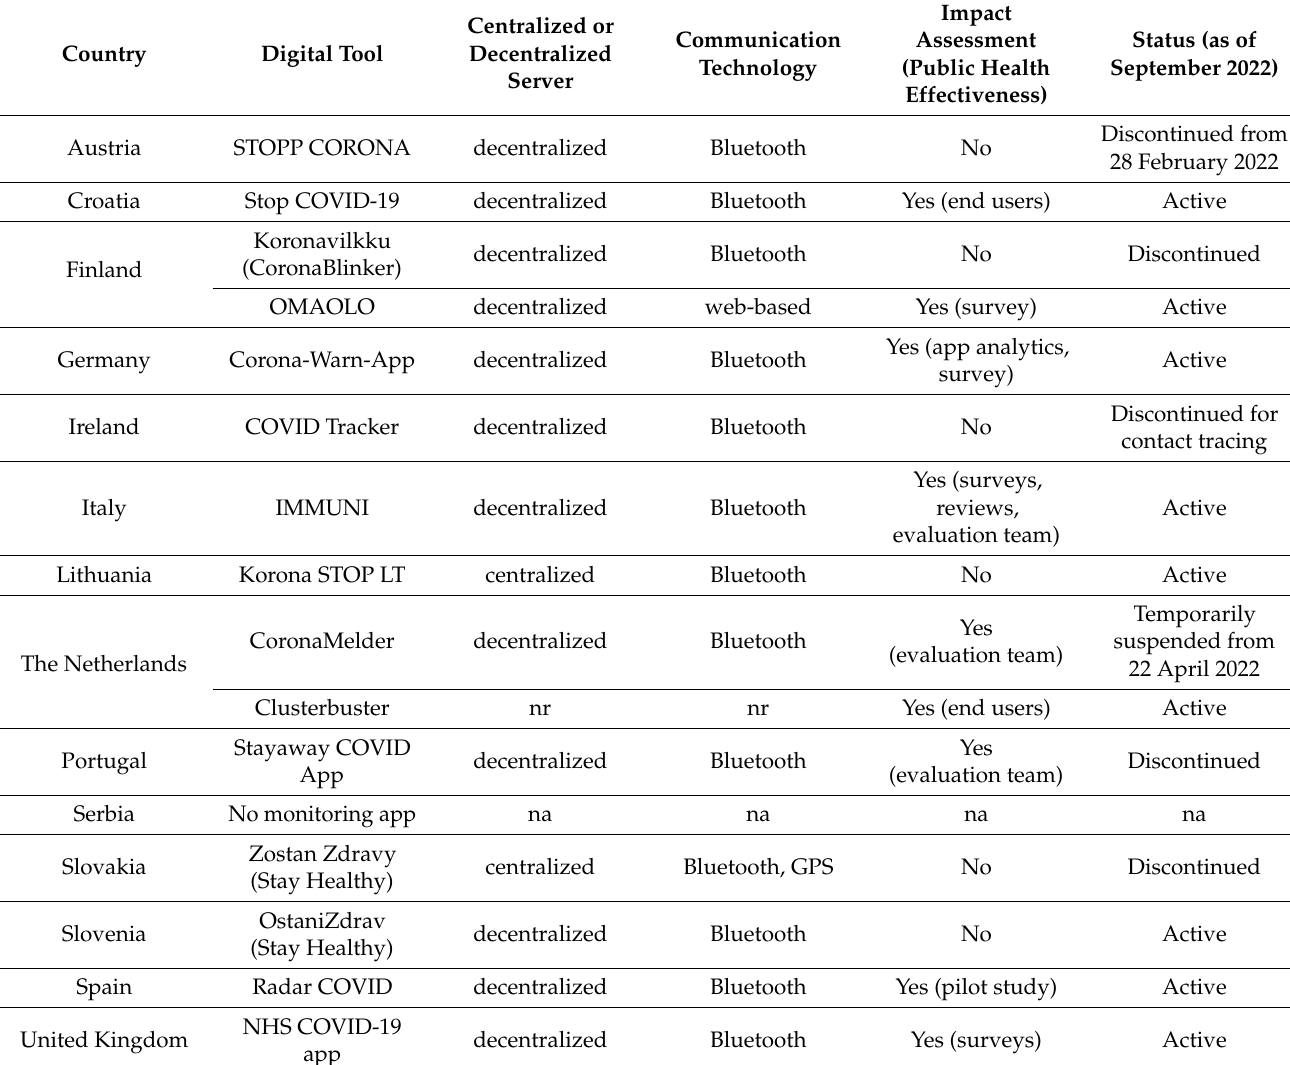
Table 2. Technical aspects and current status of digital tools used for COVID-19 monitoring in